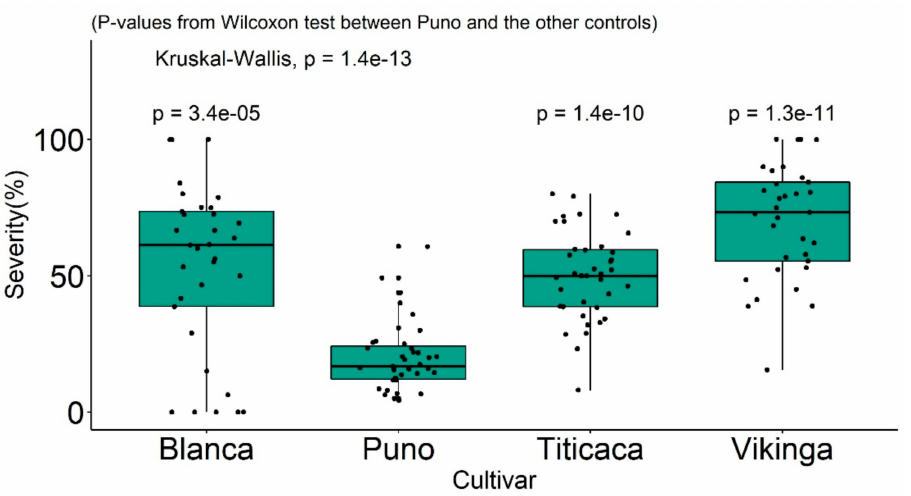
Figure 7. Reference cultivars’ responses to infection with Peronospora variabilis, measured in mean severity under greenhouse conditions. Source: Colque-Little et al.